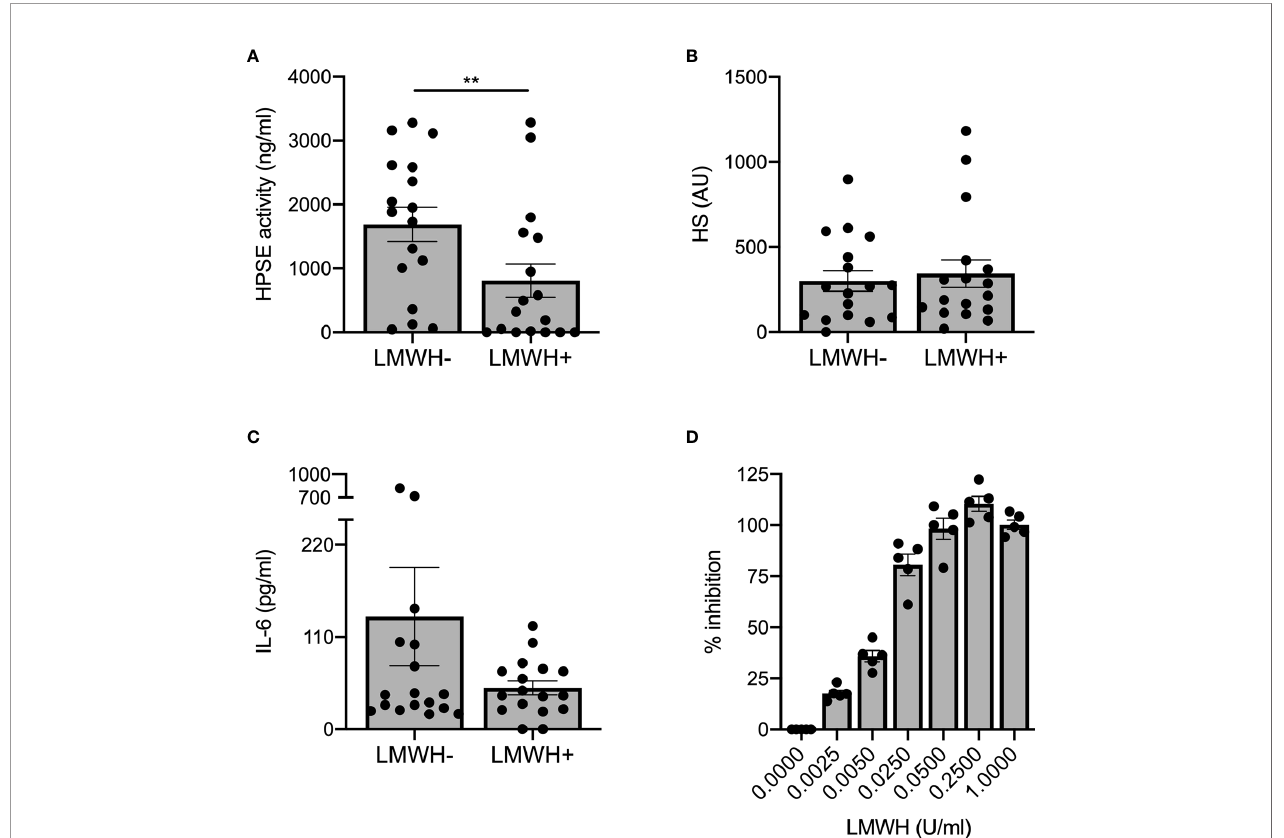
FIGURE 3 | LMWH reduces plasma HPSE activity, but not plasma HS or IL-6 levels in moderately diseased COVID-19 patients. (A) LMWH reduces HPSE activity in plasma of non-ICU patients with COVID-19, which was measured using in-house developed HPSE activity assay (n = 17 for both groups, **p < 0.01). (B) LMWH does not reduce HS levels in plasma of non-ICU patients with COVID-19, which was measured with an in-house developed competition ELISA with a speci fi c anti- HS antibody. (C) LMWH does not reduce IL-6 levels in plasma of non-ICU patients with COVID-19, which was measured using an in-house developed competition ELISA with a speci fi c anti-HS antibody. Data were presented as mean ± SEM and tested for normal distribution with D ’ Agostino & Pearson omnibus normality test and statistical difference was calculated using unpaired one-tailed Mann Whitney test. (D) LMWH inhibits recombinant HPSE activity in vitro in a dose-dependent manner. HPSE activity was measured using an in-house developed ELISA with a speci fi c anti-HS antibody (n = 5). HPSE, heparanase; HS, heparan sulfate; LMWH, low molecular weight